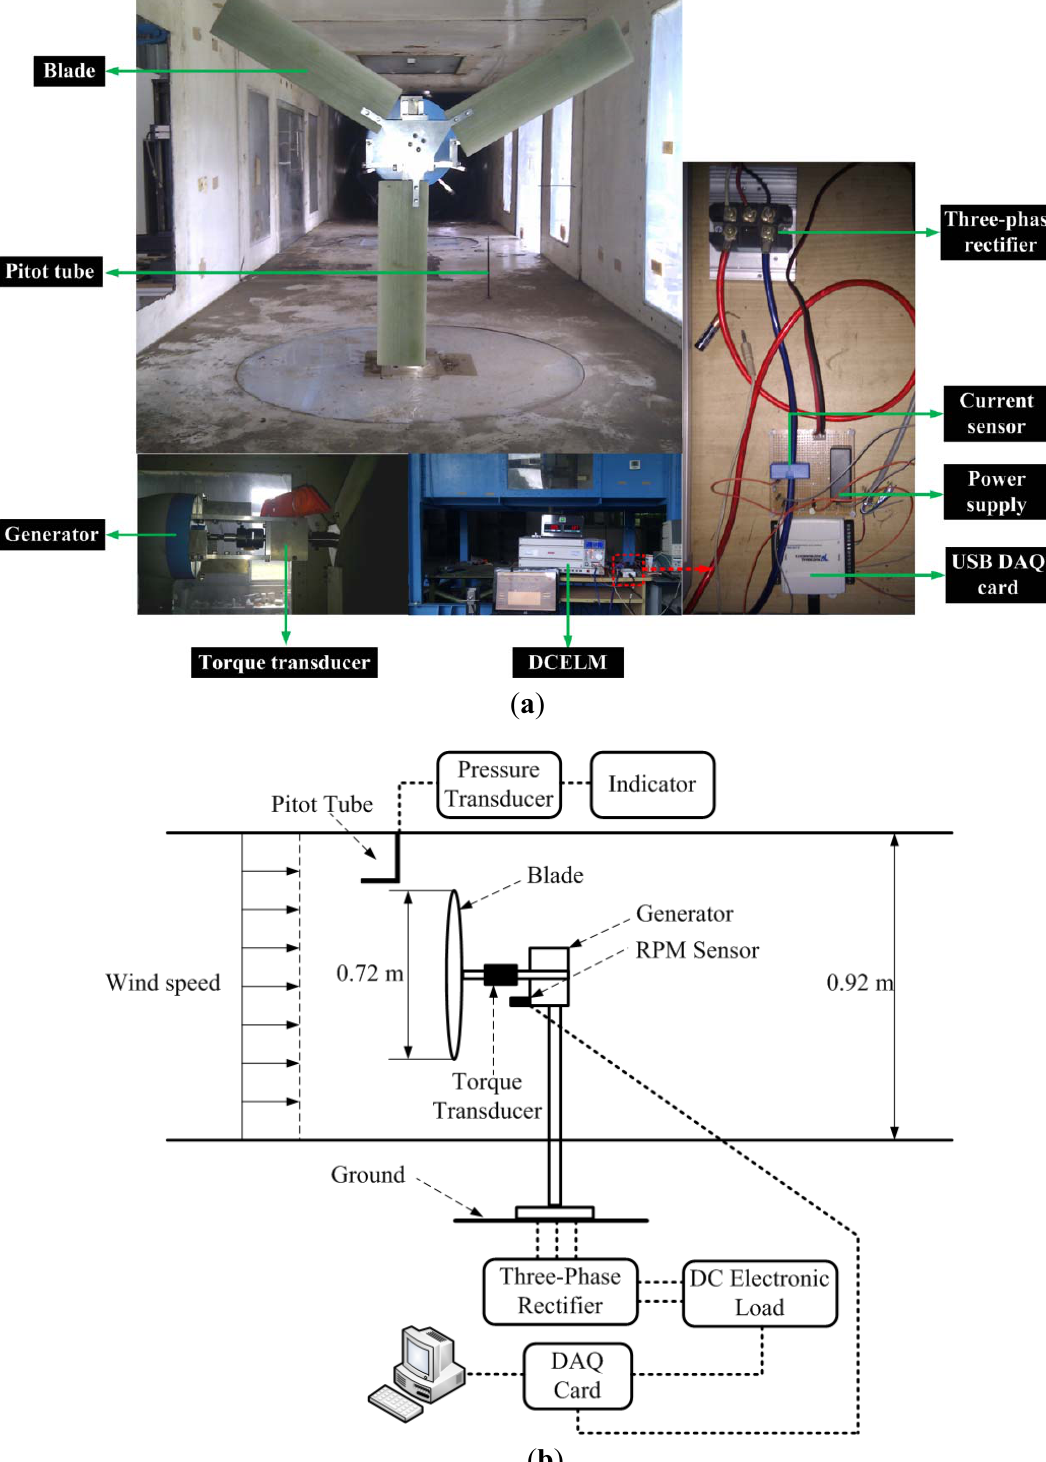
Figure 6. ( a ) The tested models setup inside the test section of full-scale wind tunnel; ( b ) The schematic of the tested models setup inside the test section of the full-scale wind